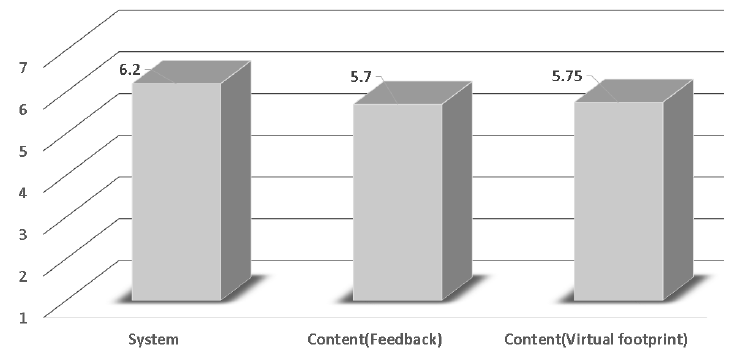
Figure 14. Satisfaction based on evaluation types.